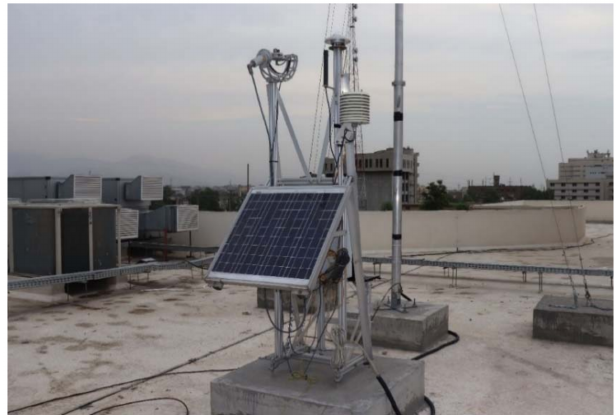
Figure 1. Weather Station established at UET